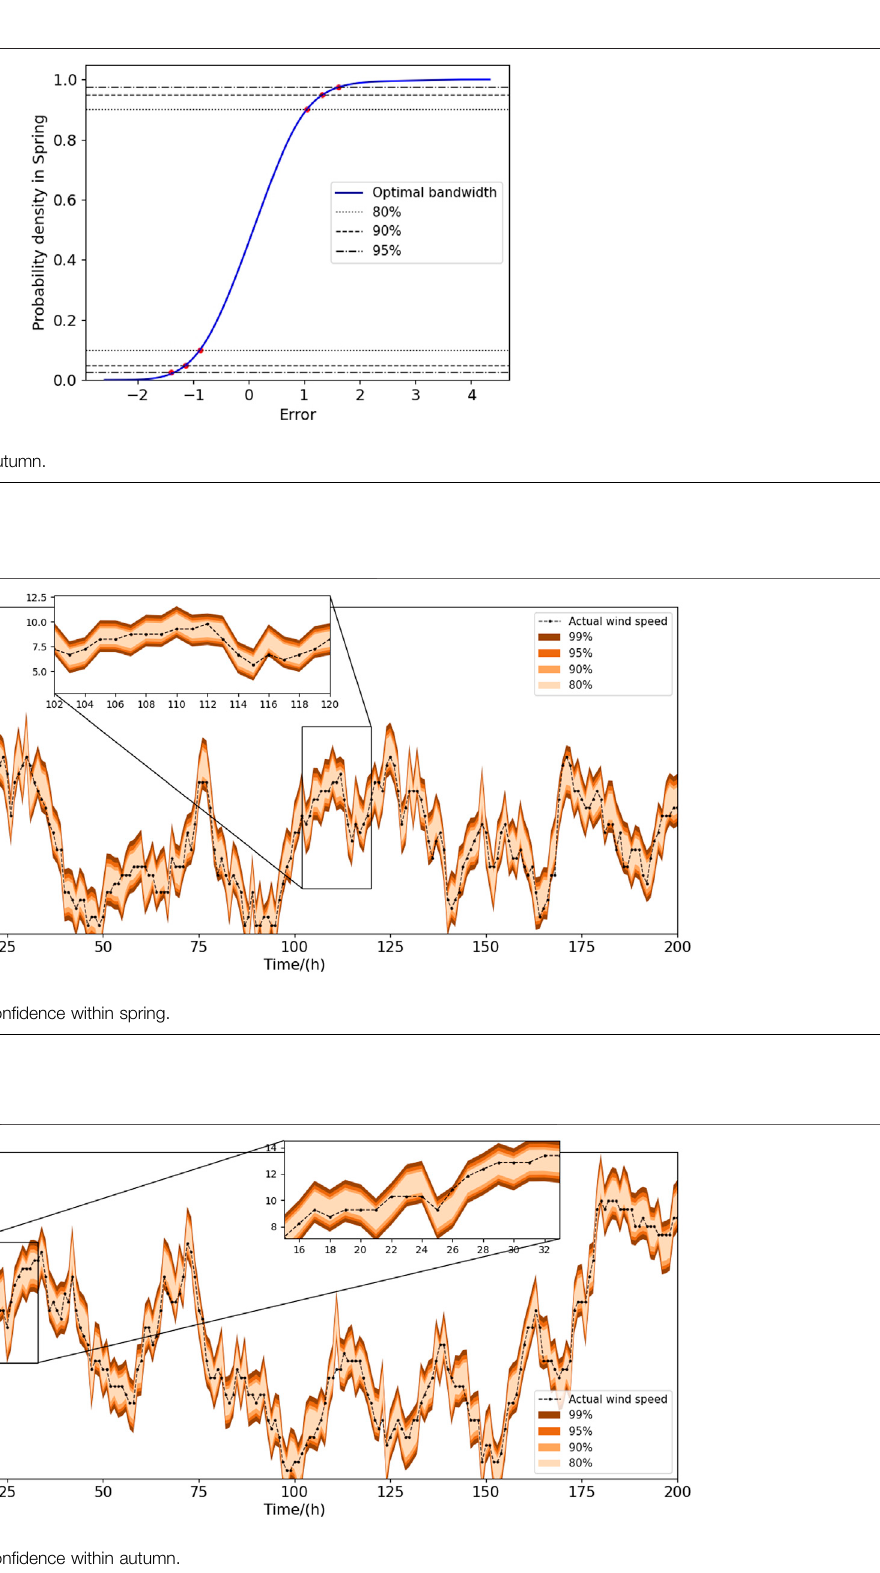
Frontiers in Energy Research |